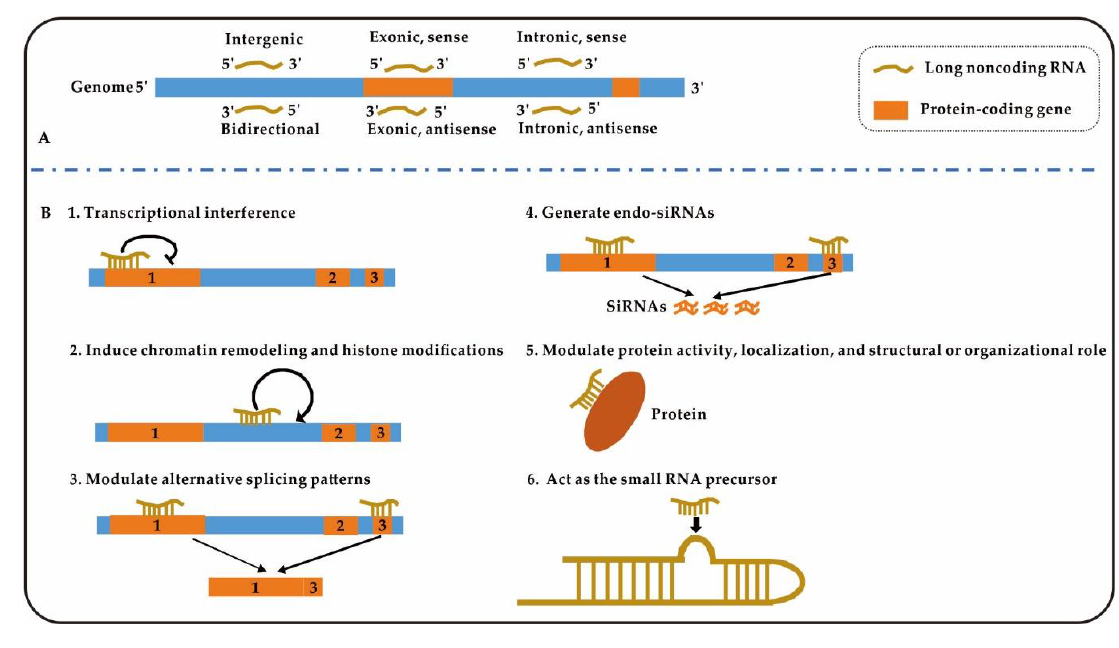
Figure 2. Classification and mechanisms of action of long noncoding RNAs (lncRNAs). 83 Classification and mechanisms of action of long noncoding RNAs (lncRNAs). ( A ), Classification of lncRNAs according to protein-coding genes; ( B ), Six mechanisms of “lncRNAs” in Figure